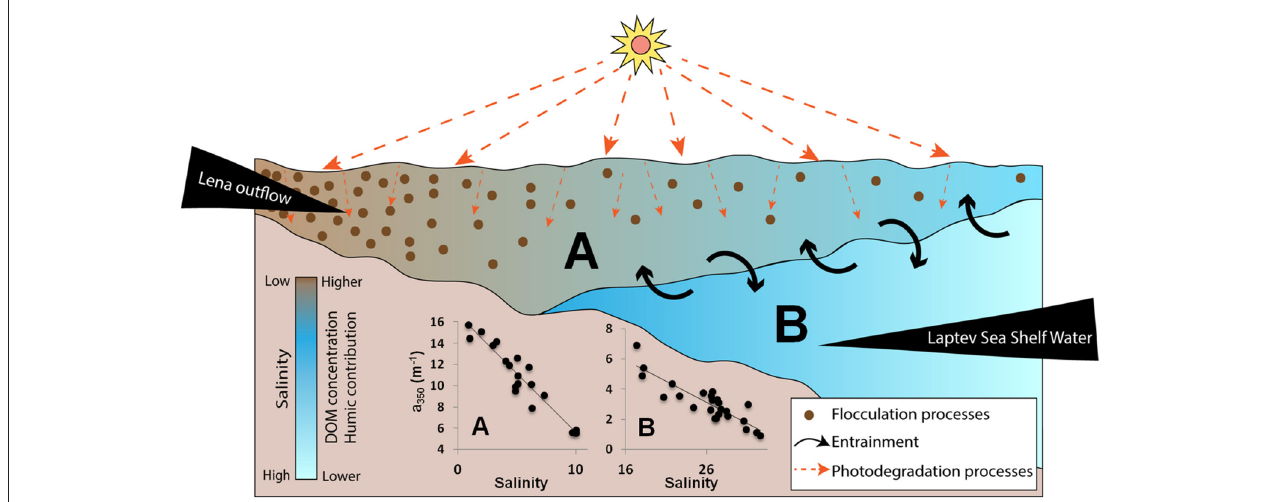
FIGURE 6 | Schematic diagram showing the complex interactions occurring in the Laptev Sea continental shelf, close to the Lena River delta region. The vertical distribution of the two water masses found within the region (Lena River plume and Laptev Sea Shelf waters) is presented. A strong gradient between the two water masses with limited exchanges between them is depicted. Salinity, DOM concentration and the humic-like contribution are shown in the colorbar. The main removal processes within the surface layer (photodegradation and flocculation) are demonstrated by the symbols presented in the inset legend. Inset graphs show the DOM (a 350 ; m − 1 ) against salinity plots for the Lena plume (A) and Laptev Sea shelf Waters (B)